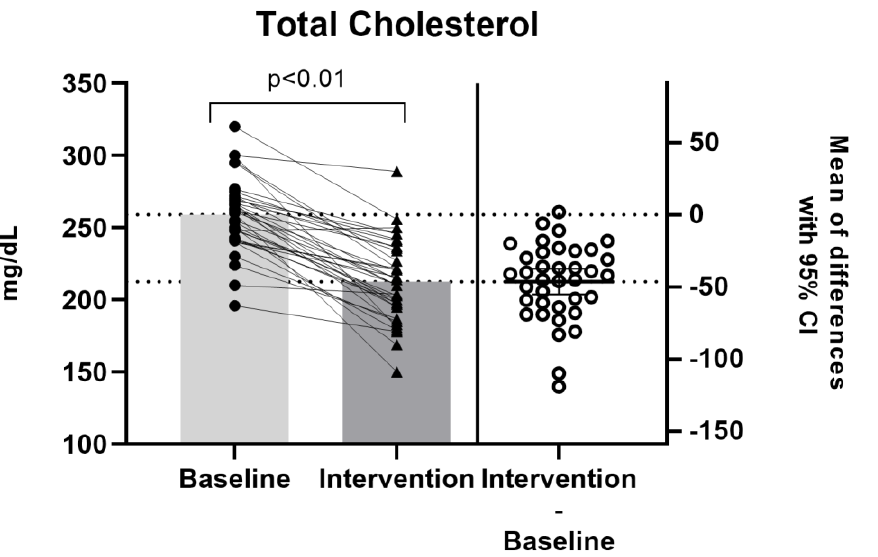
Figure 2. Total-cholesterol concentrations at baseline and after 8 weeks of intervention (mg/dL). Baseline (black circles); intervention (black triangles). Scatter plot of means of differences (white circles) with 95% confidence interval (CI). p < 0.01, paired t -test. No significant difference was observed in HDL-C levels (t 0 vs. t 8 , 63.3 ± 2.5 mg/dL vs. 63.1 ± 2.6 mg/dL, p = 0.90). A small but statistically significant decrease was